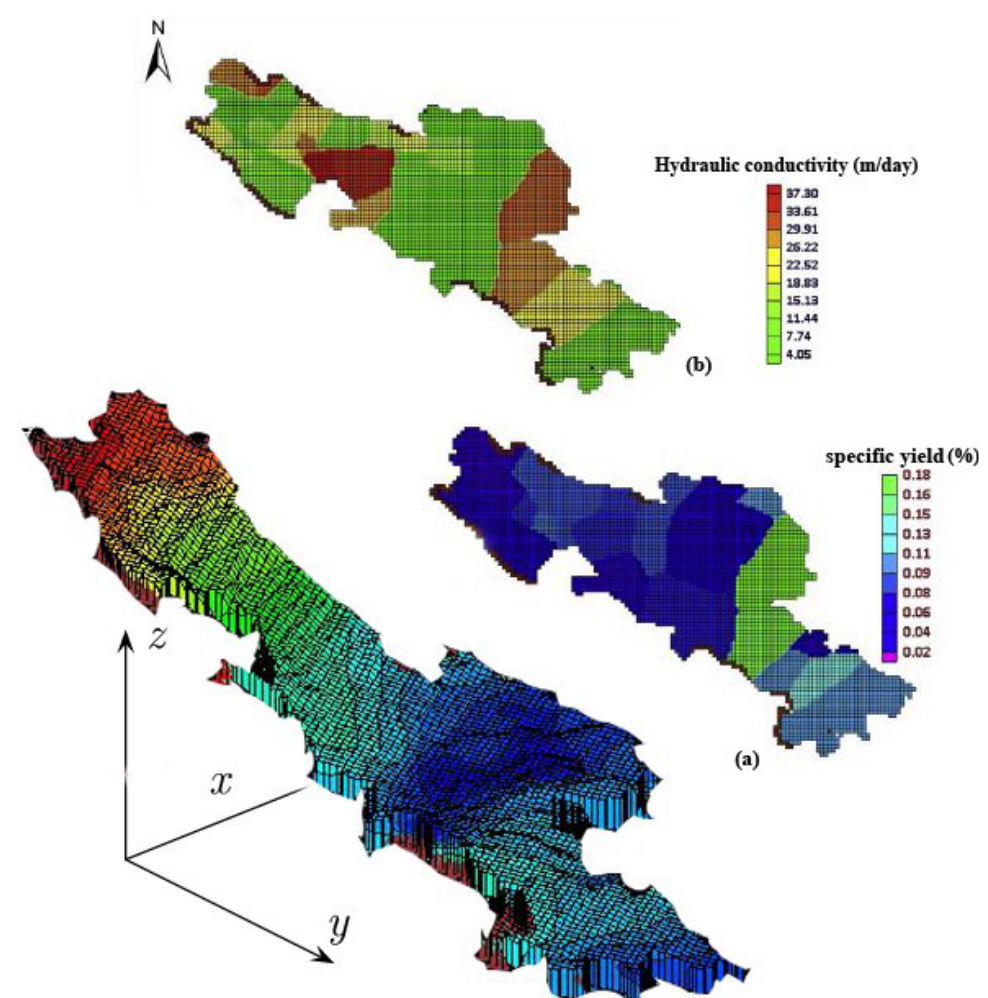
Figure 6. Groundwater model map simulated by MODFLOW, ( a ) calibrated specific yield, ( b ) cali- brated hydraulic conductivity.